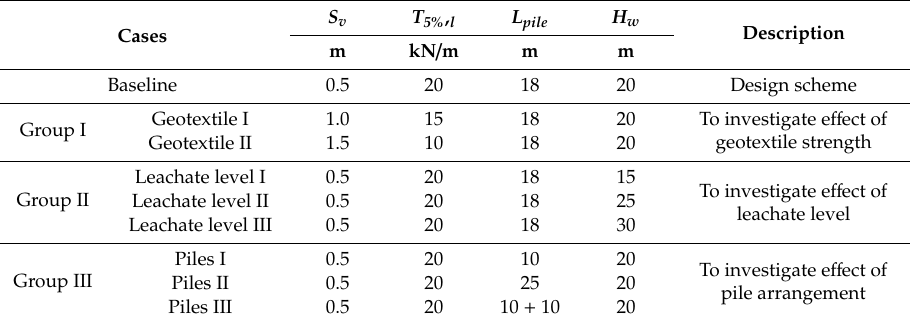
Table 2. Parametric study performed on the GRS